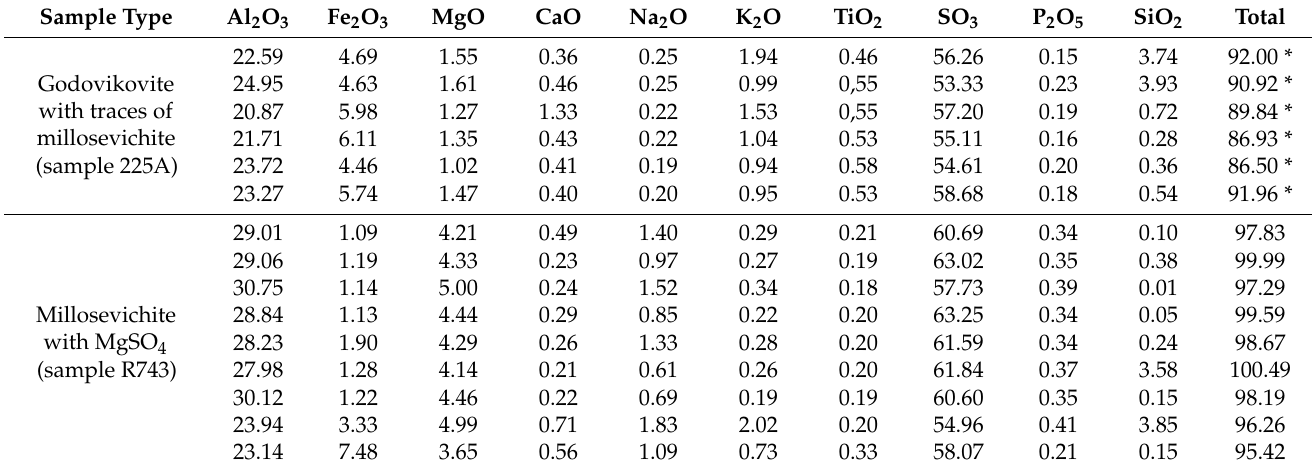
Table 1. Electron probe microanalyses (EPMA) of selected sulfates and their mixture from the Upper Silesian burning dumps (wt